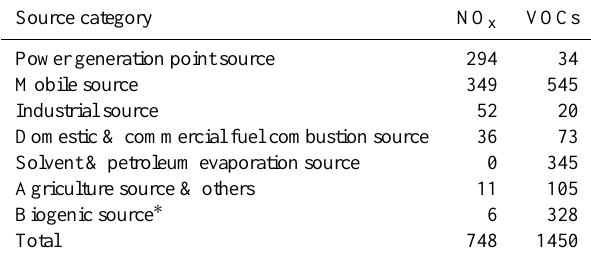
Table 1. Summary of annual emissions of NO x and VOCs by source category over the PRD in 2004